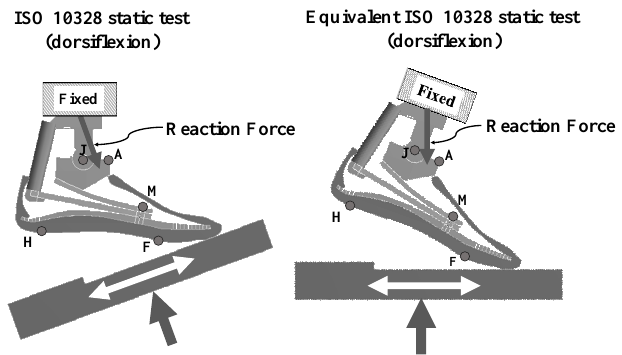
Figure 10. The ISO 10328 dorsiflexion static test compared to the equivalent test with vertical actuator.